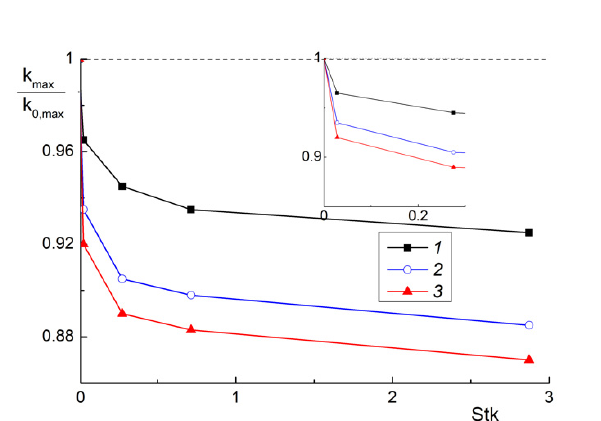
Figure 6. The effect of Stokes numbers on the maximal turbulence kinetic energy modification ratio of the gas-droplet k max to the single-phase k 0,max phases. x / H = 2, d 1 = 0–100 μ m. 1: M L 1 = 0; 2: 0.05; 3: 0.1.